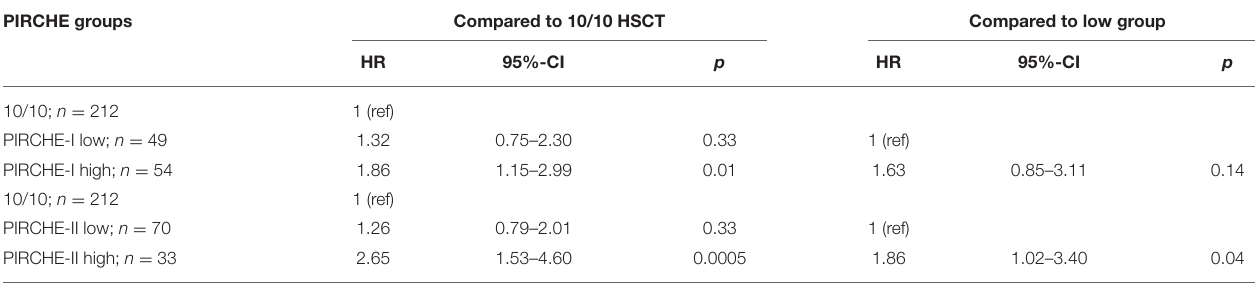
TABLE 3 | Hazard ratios of OS for PIRCHE groups compared to 10/10 or to low PIRCHE within the early-stage disease patients. PIRCHE groups Compared to 10/10 HSCT Compared to low